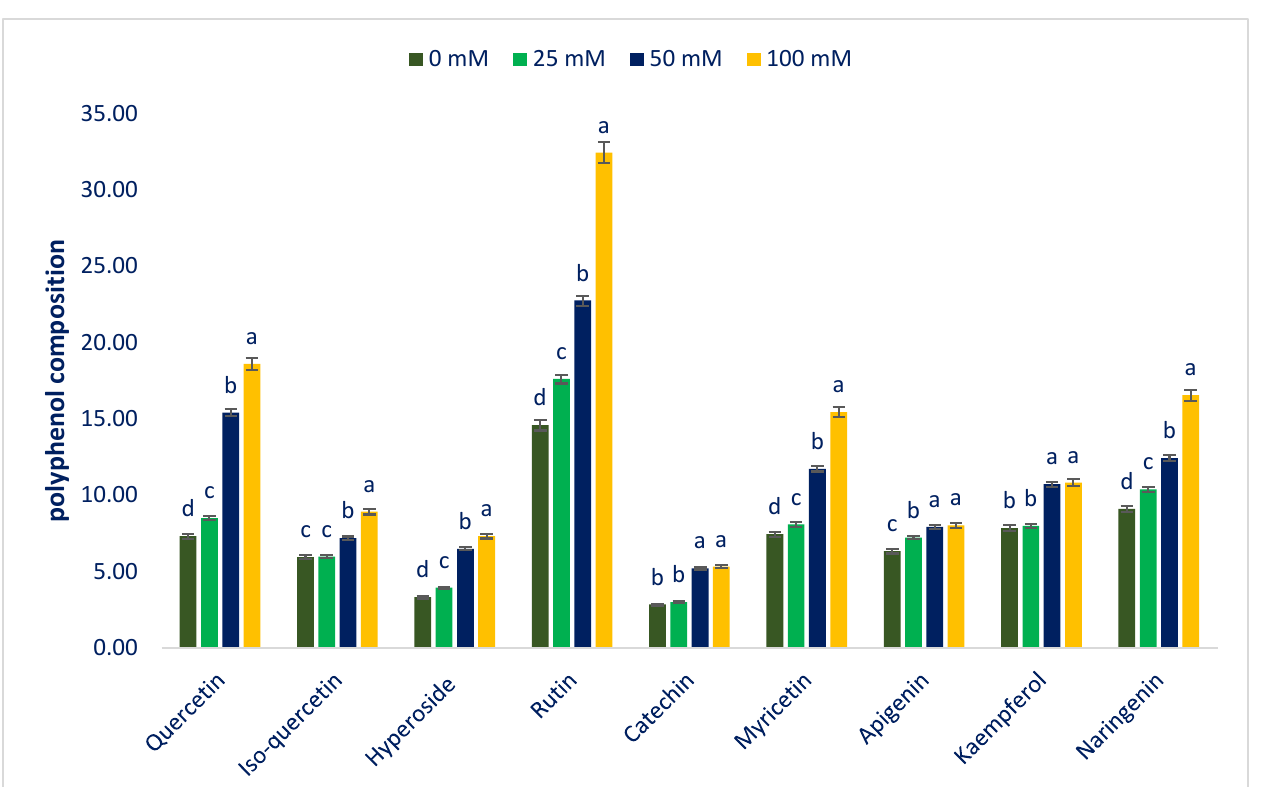
15.48, and 9.14 to 16.58 µ g g − 1 FW, respectively (Figure 9). From control to 100 mM salt concentration conditions, quercetin, rutin, hyperoside, myricetin, and naringenin were sharply and remarkably augmented by 16%, 110%, and 153%; 21%, 56%, and 112%; 19%, 95%, and 120%; 9%, 57%, and 107%; and 14%, 36%, and 81% (Figure